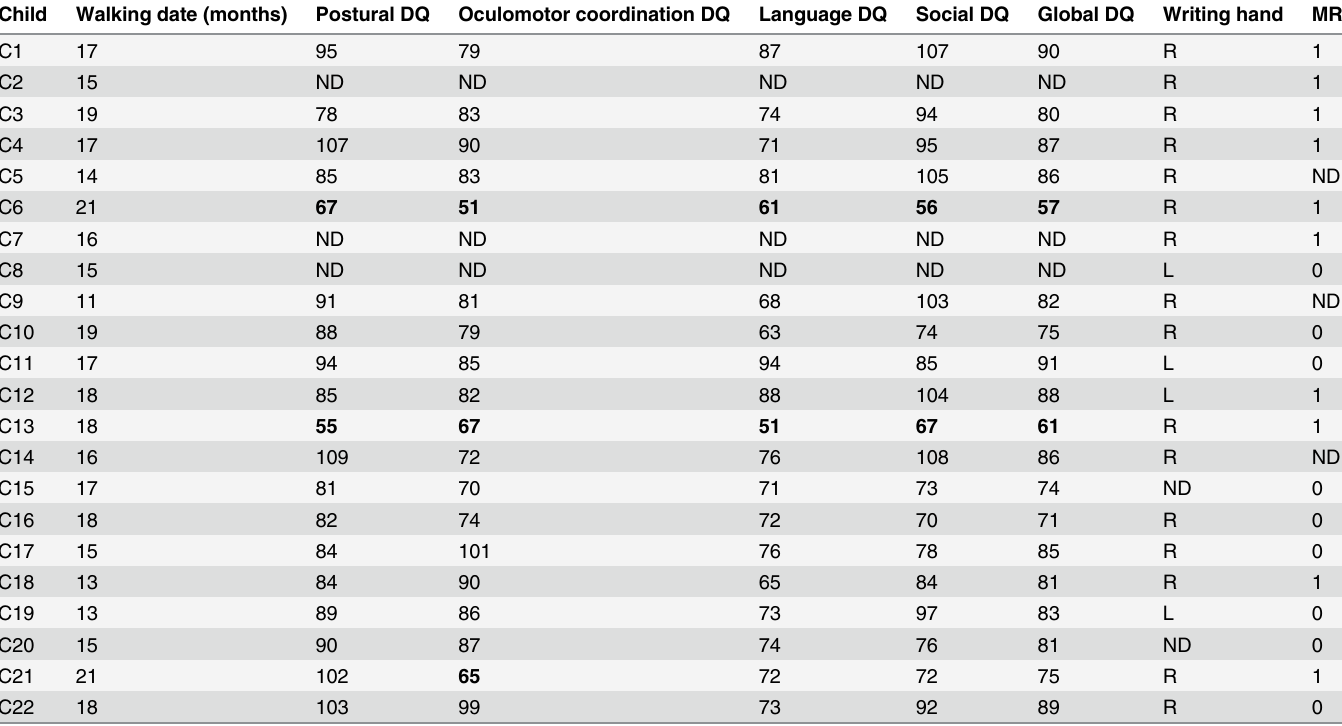
Table 2. Clinical test and MRI results in preterm children.